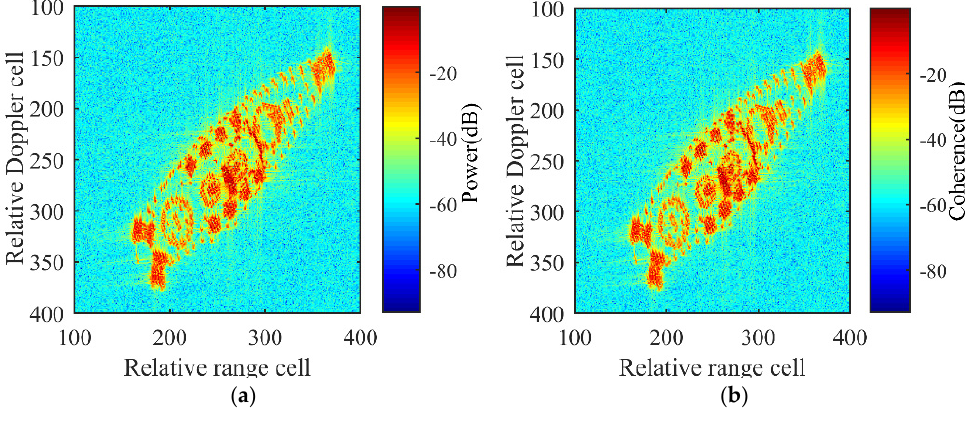
Figure 15. Coherence and power maps. ( a ) Power map. ( b ) Coherence map. The C3D detection mask from Equation (18) and 2D ISAR image received from the